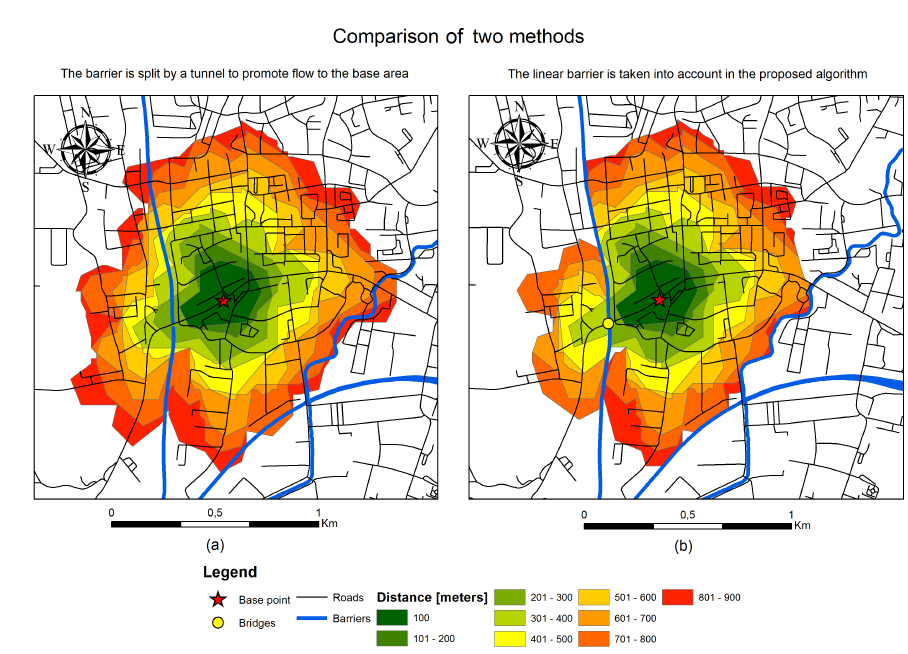
Figure 22. Service areas mapped with: ( a ) ArcGIS tool; ( b ) the proposed methodology for one